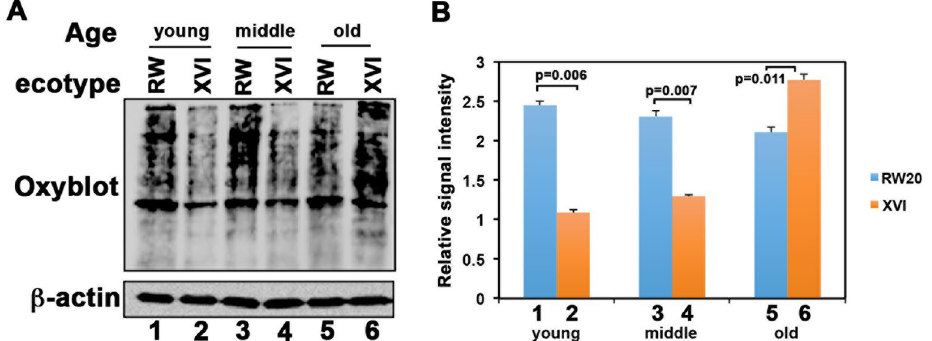
Figure 3. Oxidative damage to cellular proteins. ( A ) Protein carbonyl levels were measured with the Oxyblot kit (Millipore). Using total cellular extracts, the carbonyl groups in the protein side chains were derivatized to 2,4-dinitrophenyl hydrazine (DNP). Western blot analysis was performed with an antibody against DNP. Equal loading was assessed using an anti-β actin antibody (Sigma). Y: young (1 wk for both clones), M: middle aged (2 wk for short-lived RW20 and 4 wk for long-lived XVI-11) and O: old age (3 wk for short-lived RW20 and 8 wk for long-lived XVI-11). ( B ) Bar graph represents the signals obtained from the analysis of the average of 3 blots from various samples after normalization to the β-actin bands. Blue corresponds to short-lived RW20 and orange corresponds to the long-lived